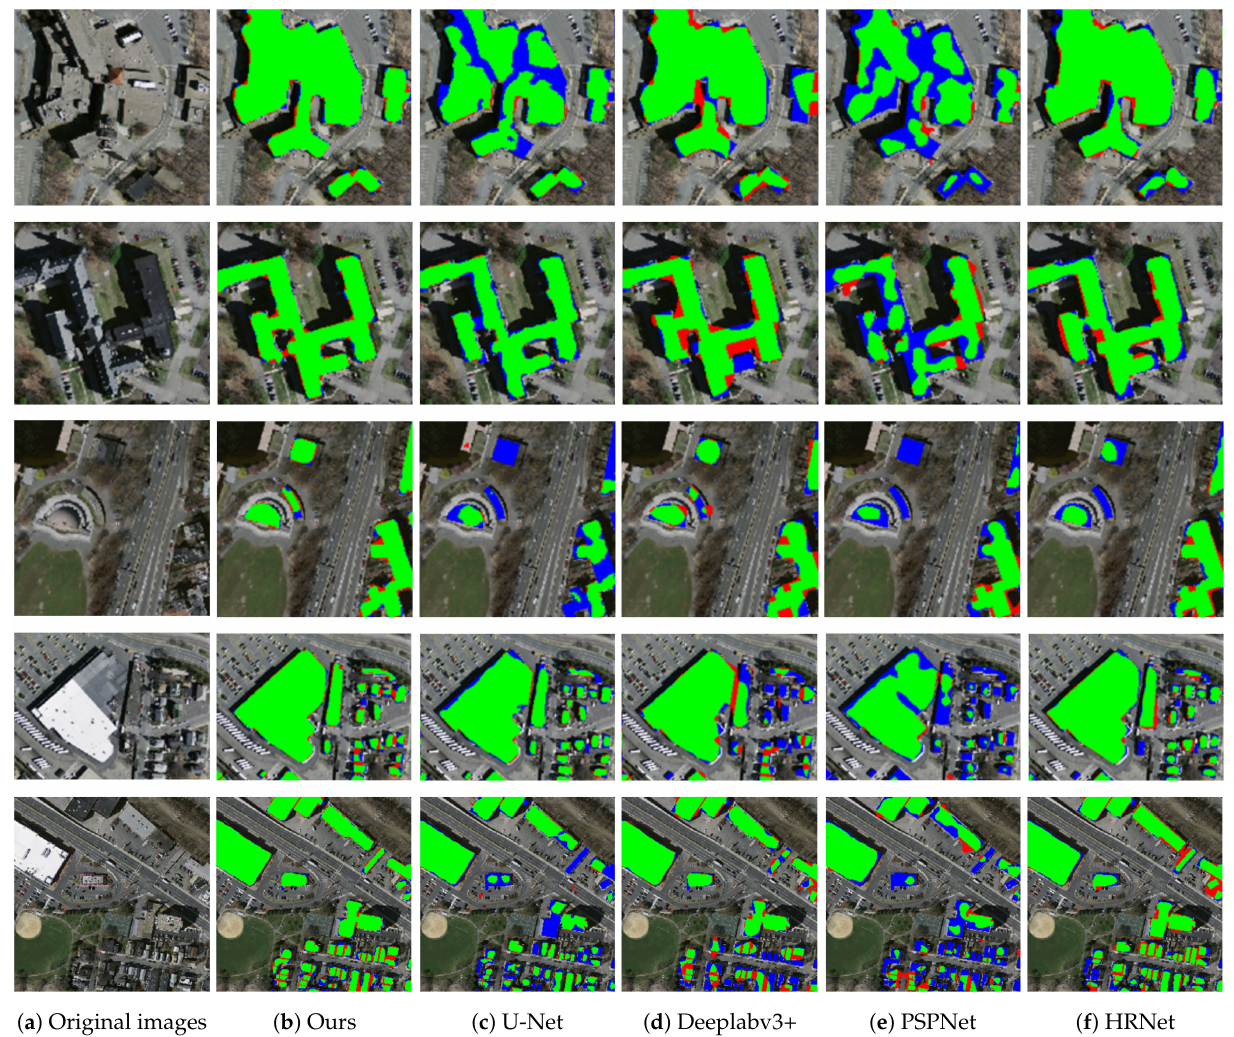
Figure 8. Extraction results of different methods for different types of buildings on the Massachusetts Building Dataset. ( a ) Original input image; ( b – f ) the results of our method and the other four methods, respectively. Green, red, and blue pixels on the map represent predictions of true positives, false positives, and false negatives,